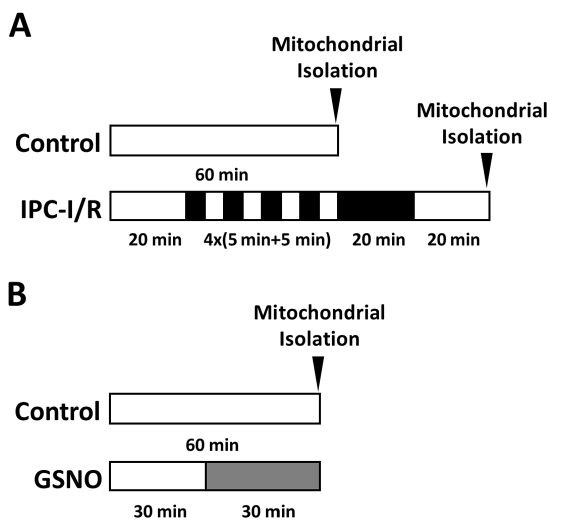
Figure 1. Myocardial perfusion protocols. Perfusion protocols for Figure 2 ( A ) and Table 1 ( B